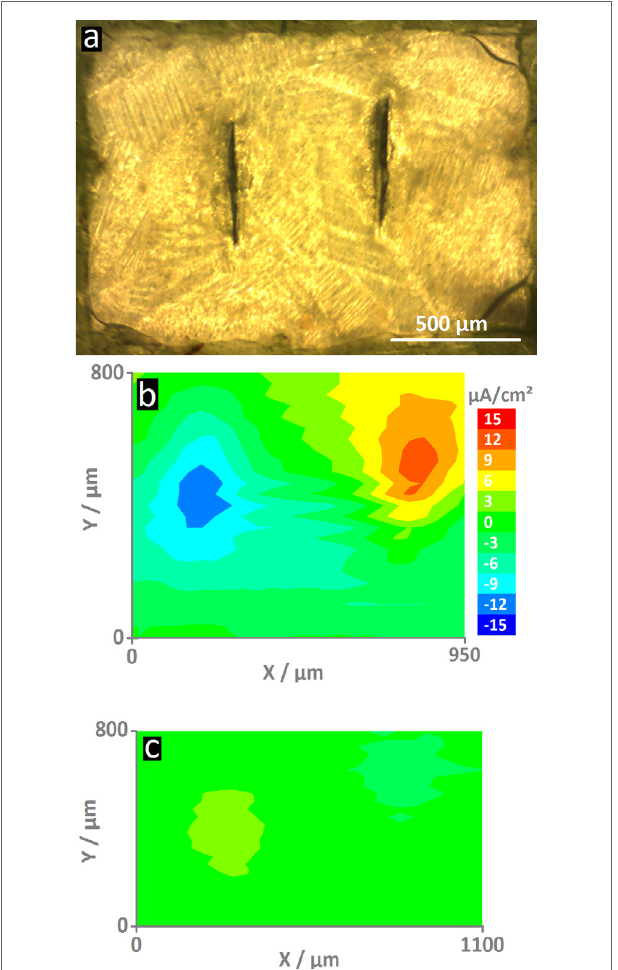
FigUre 3 | The optical micrograph (a) shows the Mash sample surface (The reference sample looks similar.) . In the center are two vertical screwdriver blade indentations that form the defects through the coating. The ionic current density maps were recorded after 4 h of immersion 100 μ m on top of the surfaces. For comparison, both maps have the same scale. The map of the reference sample (B) shows high current densities ( ± 12 μ A/cm 2 ) – an indication for the actively corroding sample. On the contrary, the sample with MLDH (c) shows much smaller current densities and thus corrosion inhibition.